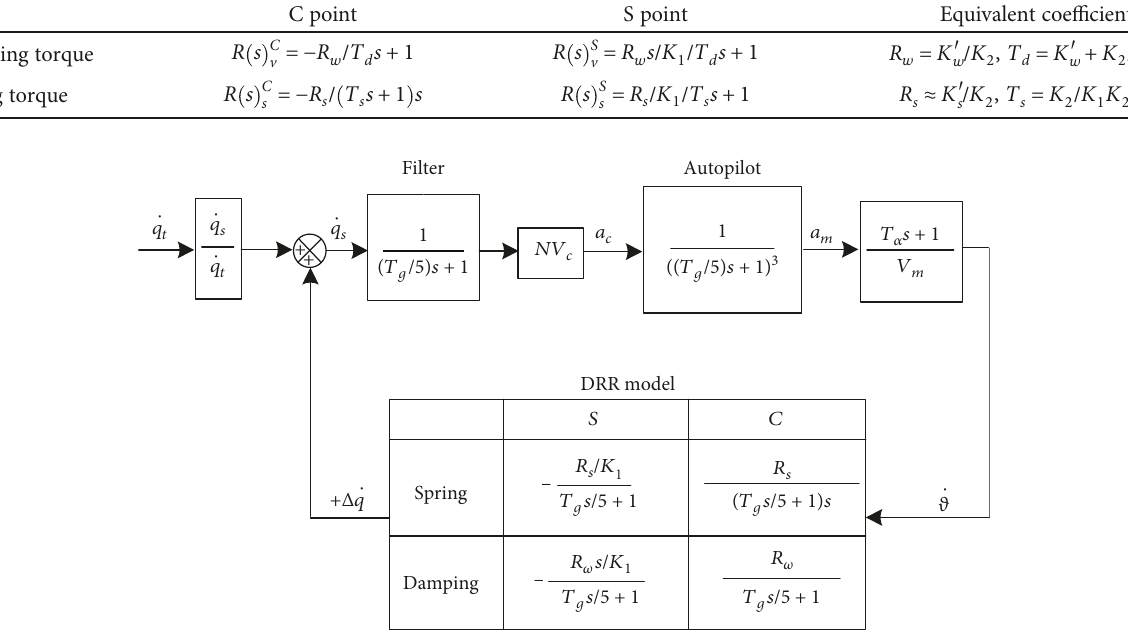
Figure 7: The simple structure of the DRR parasitic